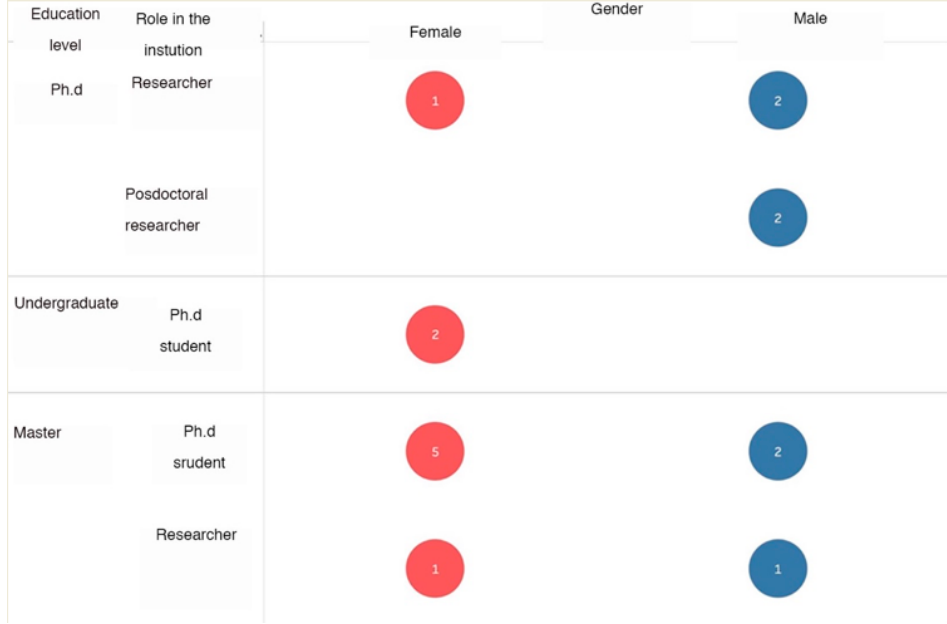
Figure 1. Demographic information of the focus group participants, gender, and education level. (own elaboration). To identify the level of repository use, the survey asked, “Have you used the repos- itory?” 50% of the participants chose the answer, “I do not know of the existence of an institutional repository and its purpose.” 25% chose, “I have uploaded papers at the request